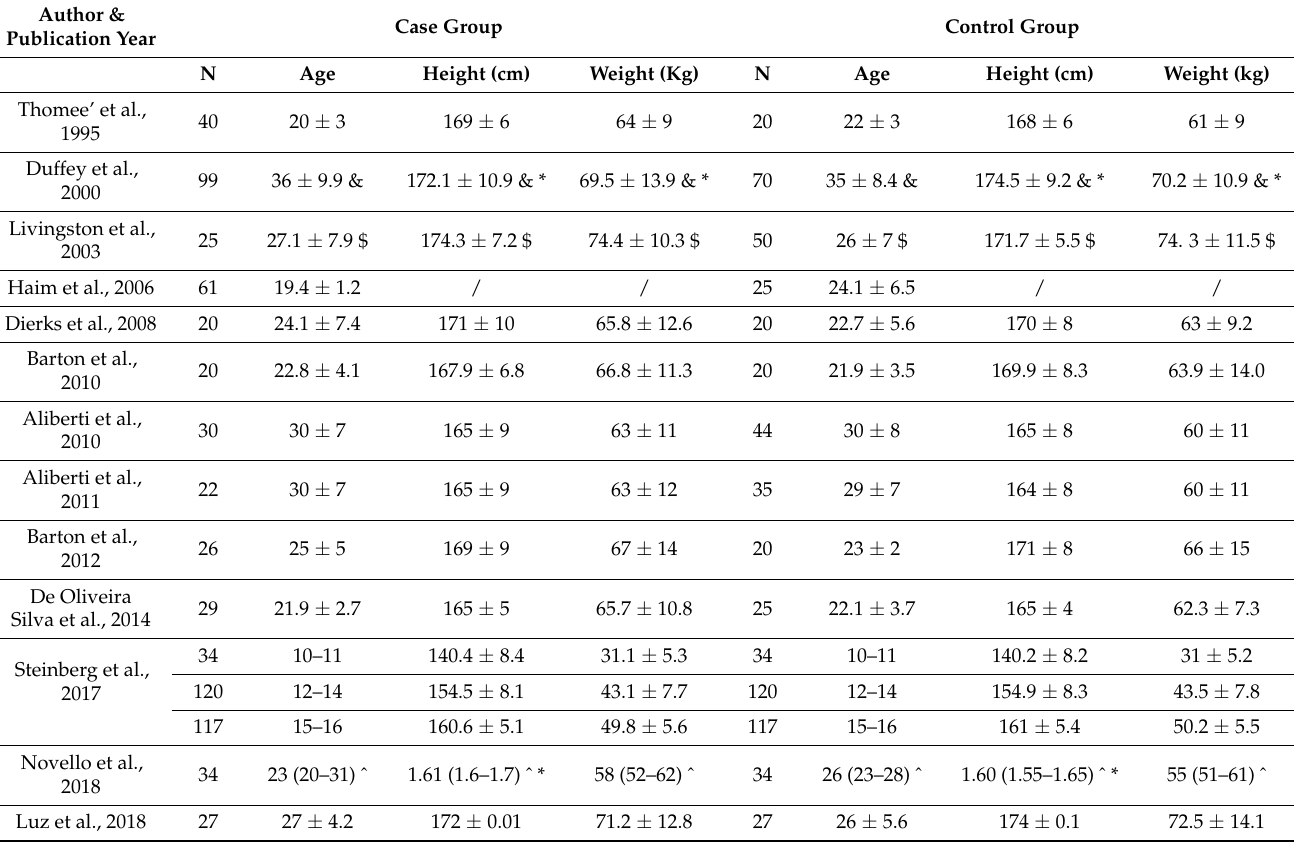
Table 2. Group general